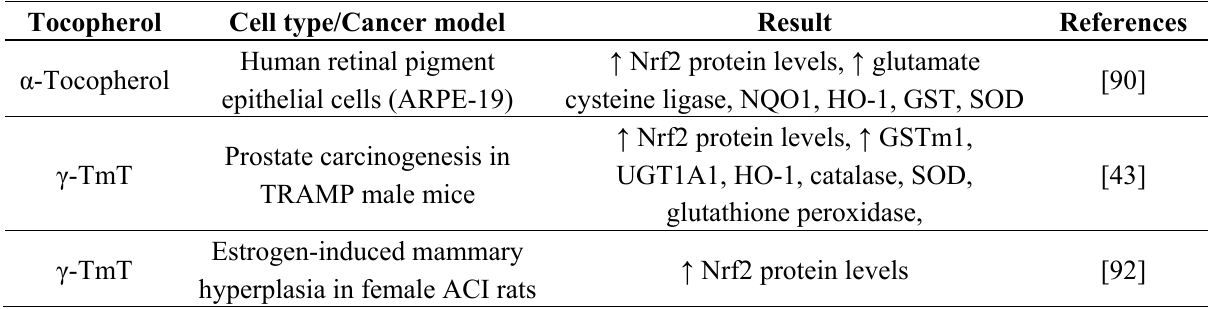
Table 2. Tocopherols induce Nrf2 and related antioxidant